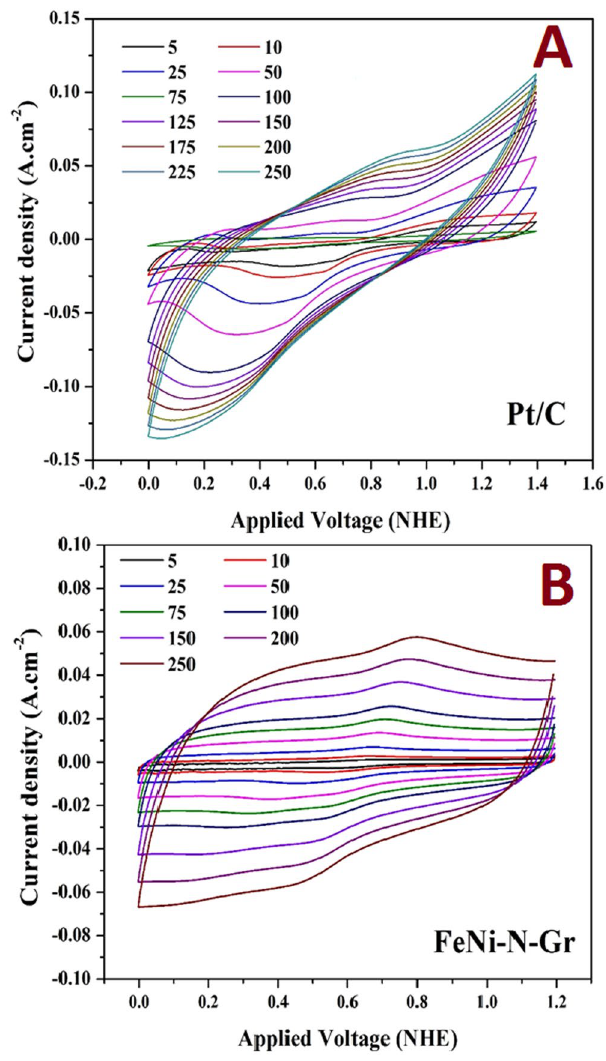
Figure 7. Cyclic voltammetry results for the introduced FeNi-N-Gr and Pt/C electrodes at different scan rates in 0.5 M H 2 SO 4 at room